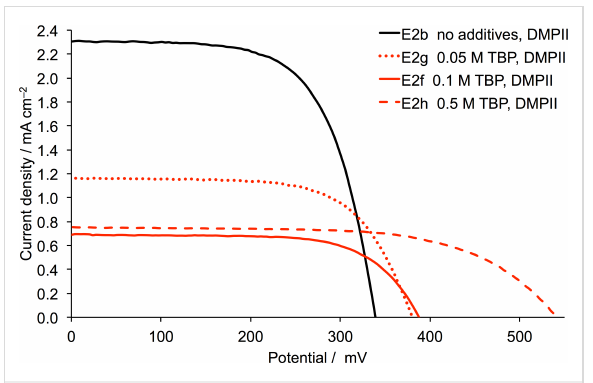
Figure 6: J–V curves for DSCs with dye 1 and electrolytes with TBP additive.